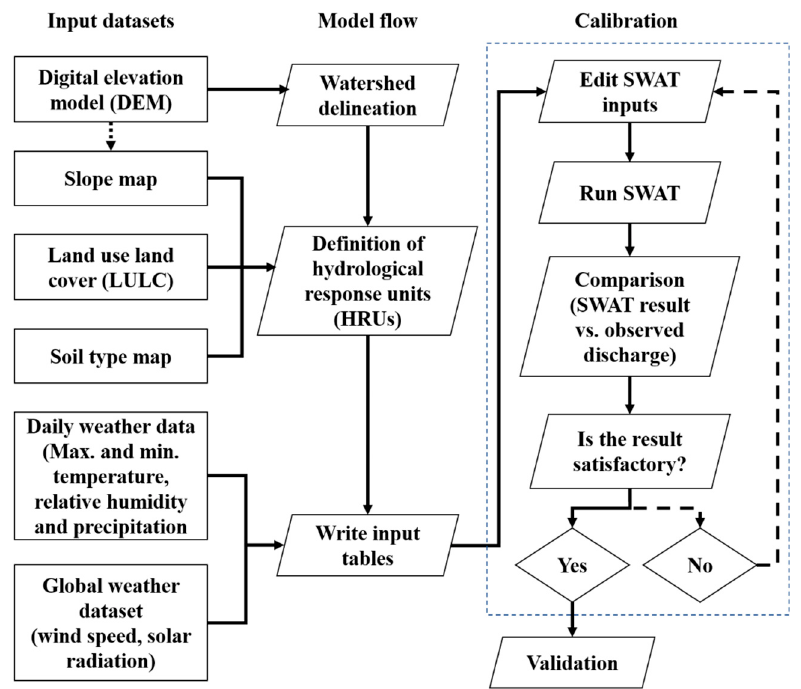
Figure 5. Flowchart for SWAT hydrological modelling in this study.